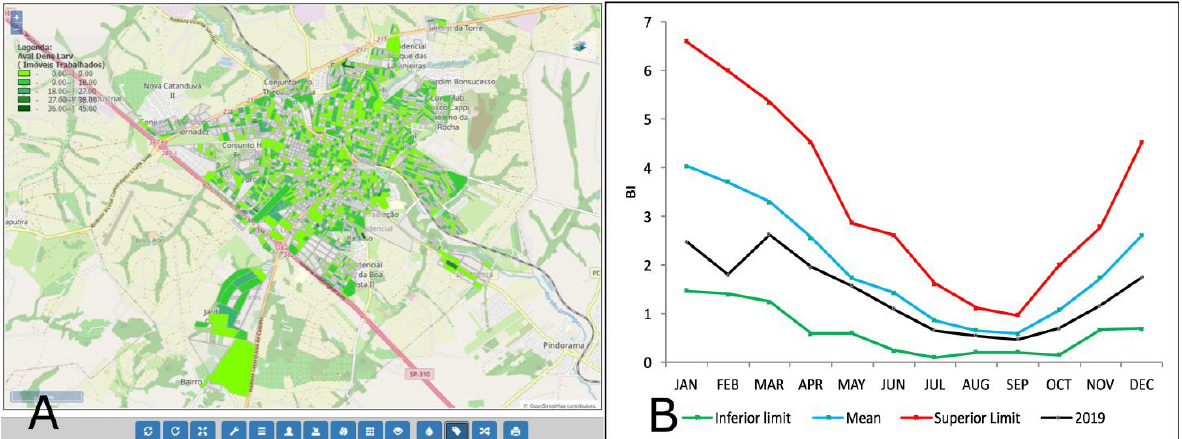
Figure 9 . ( A ) Breteau Index—Evaluation of Larval Density in the county of Cantaduva, SP, Brazil, 2019: distribution per block per range of values; ( B ) Control diagram, monthly average rate and standard deviation of Breteau Index (BI) in 2019. Note: Legenda = Subtitle; Aval. Den. Larv (Imóveis Trabalhados) = Larvae Density Index (Collection Properties).